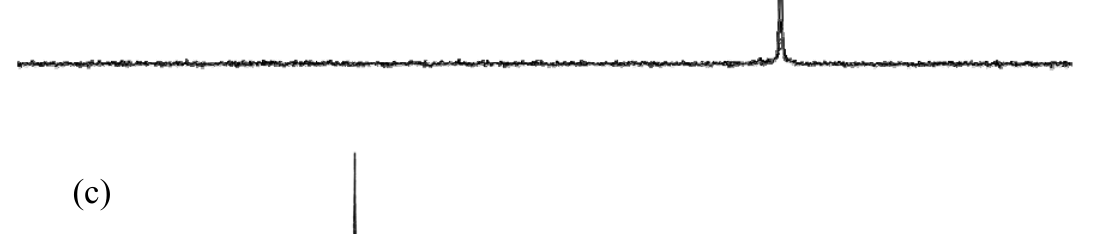
H[[{Ti(H O) } ( μ -O)]( α -PW Ti O )] ·9H O ( K-1 ) in 5 2 3 2 9 2 38 2 2 [{Ti ( μ -O) (SO ) (H O) }( α -PW O )]·6H O ( K-2 ) in aqueous 3 4 3 4 2 2 8 9 34 2 SO , and (c) K H [( α -1,2,3-PW Ti O ) O ]·15H O as a precursor in 2 4 10 2 9 3 37 2 3 2